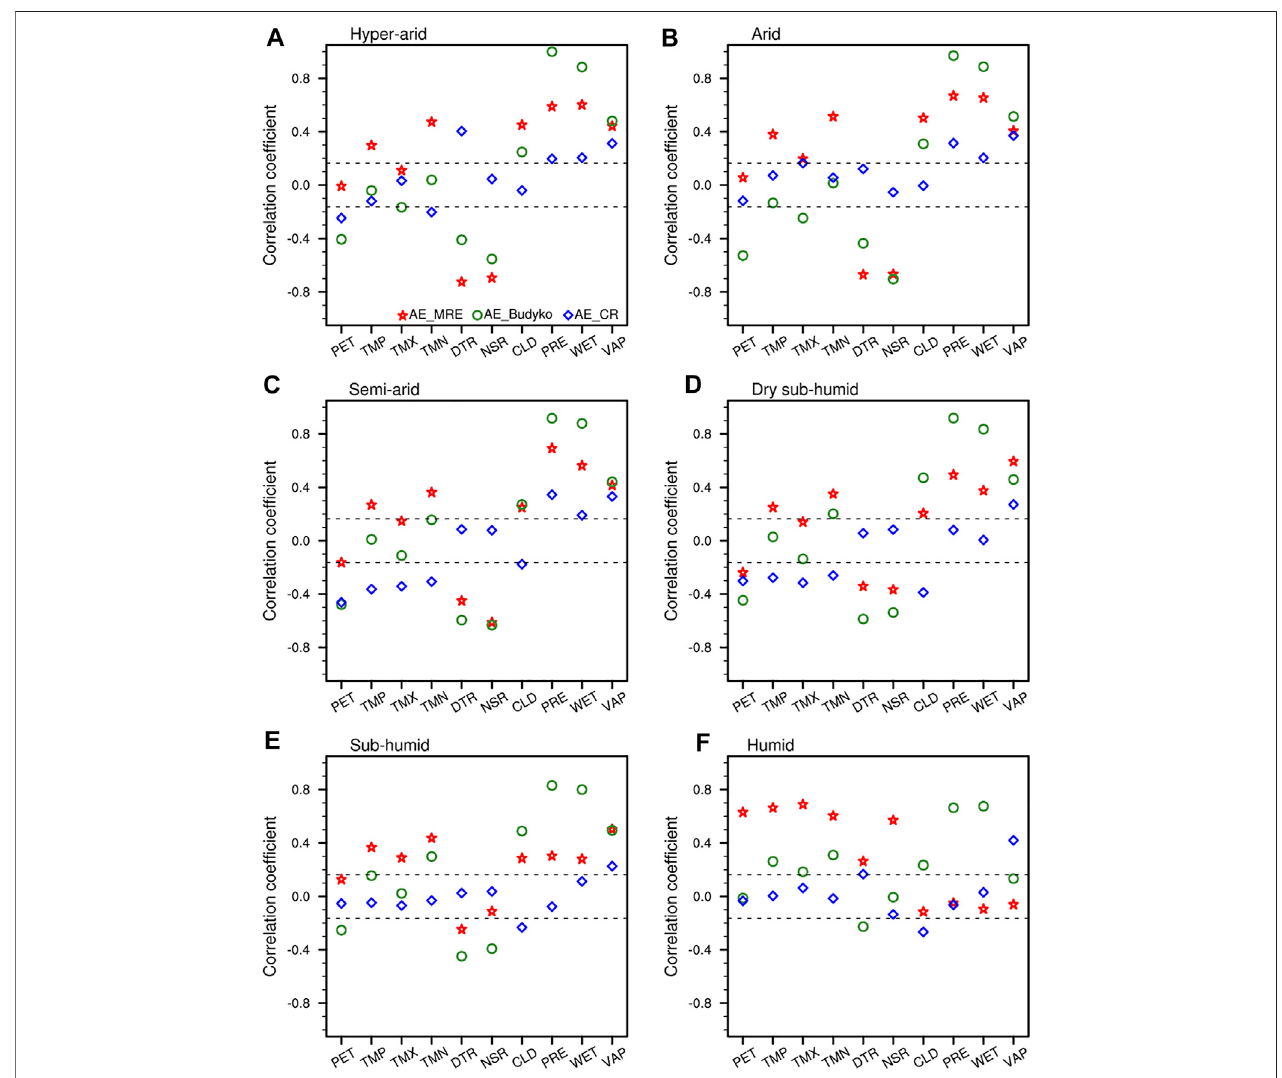
FIGURE 7 | Temporal correlation coef fi cients between X-12-ARIMA trend components of actual evapotranspiration and in fl uencing factors, namely potential evapotranspiration (PET), mean temperature (TMP), maximum and minimum temperatures (TMX and TMN, respectively), diurnal temperature range (DTR), net solar radiation (NSR),cloudcover (CLD), precipitation(PRE), wet-dayfrequency(WET), and vapor pressure (VAP), over the (A) hyper-arid, (B) arid, (C) semi-arid, (D) dry sub- humid, (E) sub-humid, and (F) humid regions from 1982 to 2015. The local 99.9% con fi dence levels are about ± 0.164 based on Student ’ s t-test.